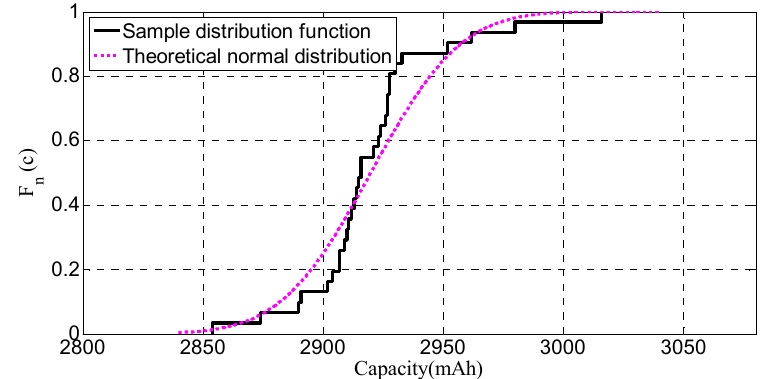
Figure 8. The distribution function and theoretical normal distribution function of the capacity samples after vibration.